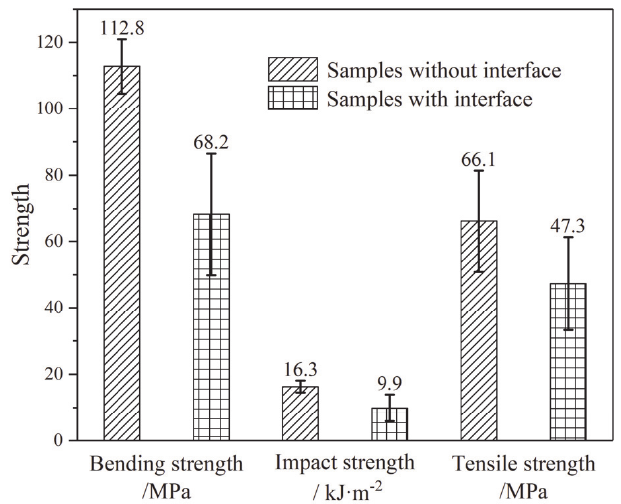
Figure 7. Mechanical strength of samples with or without interfaces.